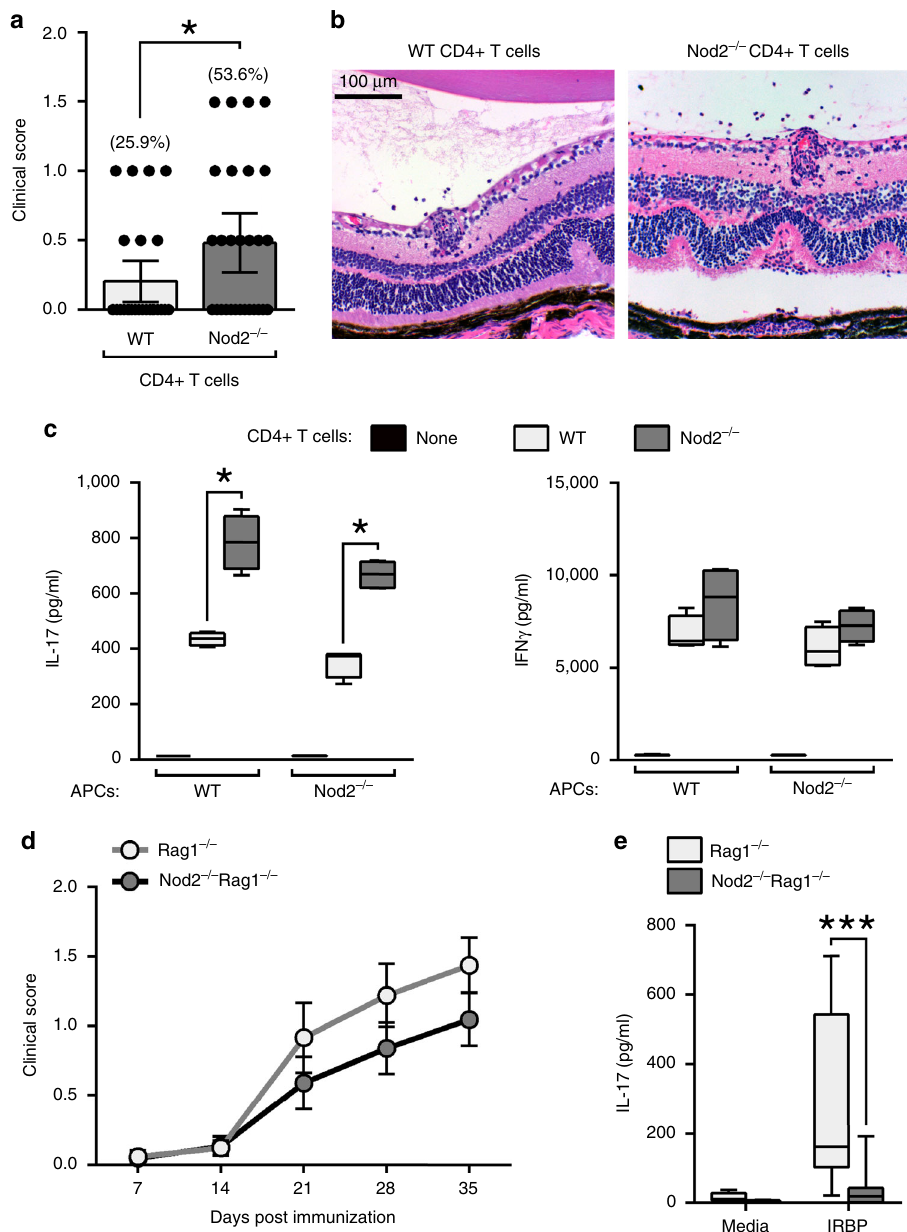
Fig. 4 Nod2 suppresses uveitis through a non-conventional cellular mechanism. a – b CD4 + T cells from IRBP-immunized donor WT or Nod2 − / − mice were adoptively transferred into naïve WT recipients. a Clinical uveitis scores and incidence 20 days post-transfer. Data are from 6 independent experiments with n = 27 (WT) and 28 (Nod2 − / − ) mice; * p = 0.0336. b Representative photos of WT recipients of WT or Nod2 − / − CD4 + T cells 20 days post-transfer. c IL-17 and IFN- γ were measured by ELISA following 18 h stimulation with IRBP 1 – 20 (20 µ g/ml) of co-cultured APCs (isolated from naïve WT or Nod2 − / − mice) and CD4 + T cells (isolated from WT or Nod2 − / − immunized mice). Control APCs without the addition of T cells ( “ none ” ) were stimulated with IRBP. Data are combined from 4 independent experiments. For each experiment, APCs or T cell populations were isolated from n = 3 pooled mice/genotype; * p = 0.0286 for comparisons with both APC conditions. d – e Rag1 − / − or Nod2 − / − Rag1 − / − mice were reconstituted with WT CD4 + T cells and immunized with IRBP 24 h later. d Clinical uveitis was evaluated weekly. Data is combined from 3 independent experiments. For Rag1 − / − recipients n = 16 (7 days), 20 (14 days), 18 (21 and 28 days), 16 (35 days). For Nod2 − / − Rag1 − / − recipients n = 20 (7 days), 22 (14, 21, and 28 days), 20 (35 days). e Splenocytes were stimulated 18 h in vitro with IRBP 1 – 20 and IL-17 in culture supernatants was measured by ELISA. Data are combined from 3 independent experiments with n = 12 (Rag1 − / − media), 18 (Nod2 − / − Rag1 − / − media), 13 (Rag1 − / − IRBP), 15 (Nod2 − / − Rag1 − / − IRBP) mice; *** p = 0.0001. Data are mean ± SEM ( a , d ) with dots representing individual values ( a ) or box-whisker plots with median, 25 – 75th percentile and min – max range ( c , e ). Statistical differences between groups were calculated using unpaired, two tailed Student ’ s t -test ( a ), two-tailed Mann – Whitney U test ( c , d , e ). Source data are provided as a Source Data fi